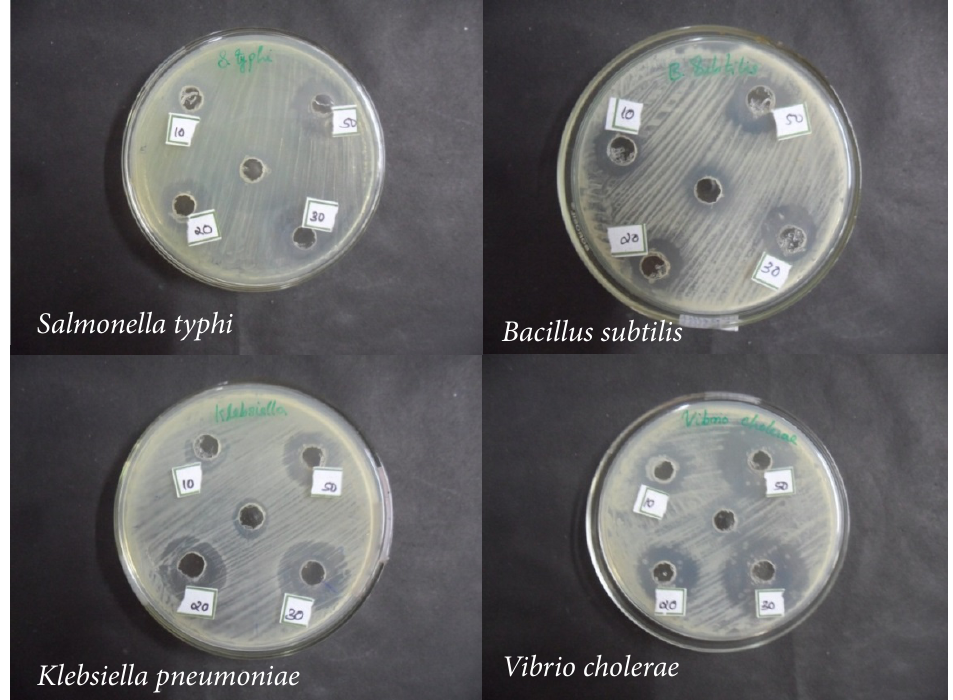
Fig. 8. Antimicrobial activity of silver nanoparticle synthesised by pellet of Escherichia coli Table 3. Minimum Inhibitory Concentration of Silver nanoparticles synthesized from Escherichia Minimum Inhibitory Concentration (µg/ml) Organism